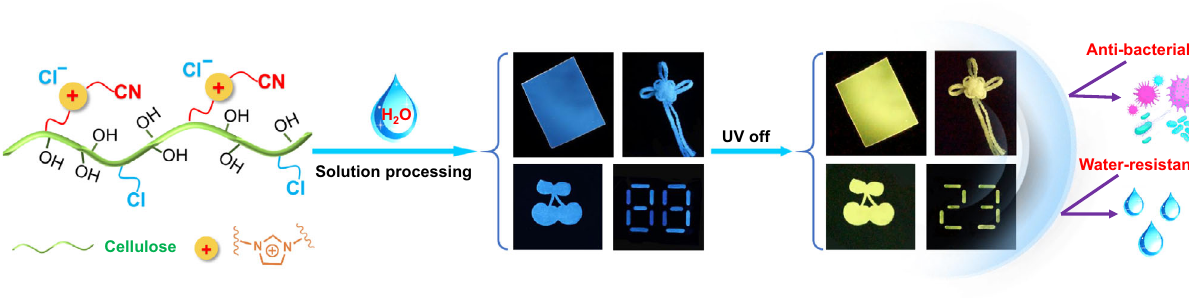
Fig. 1 Phosphorescent Cell-ImCNCl. Chemical structure, processability, and performance of the cationic cellulose derivative Cell-ImCNCl with RTP